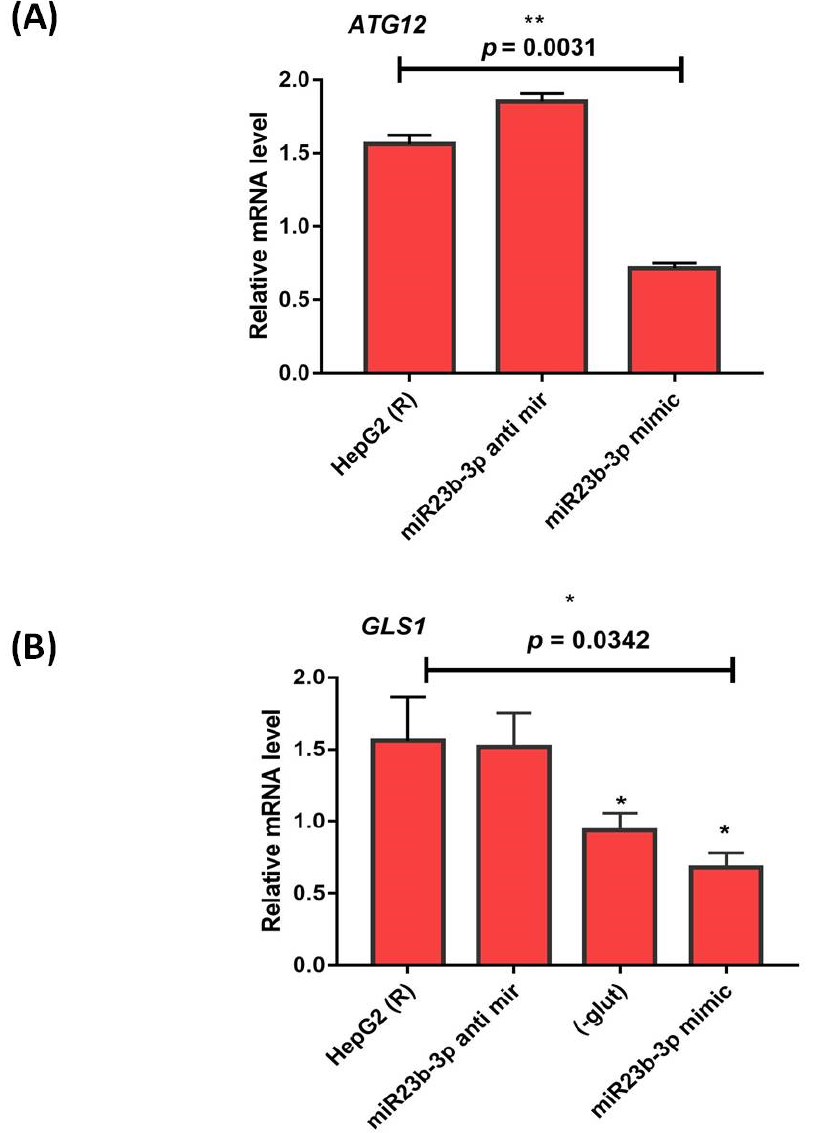
Figure 10. ( A ) ATG12 expression analysis ( B ) GLS1 expression analysis in presence of miR-23b-3p mimic (miR-23m) and antimiR (30 nM) in sorafenib resistant HepG2 cells [R; sorafenib resistant HepG2 cells] (* p ≤ 0.05); (** p ≤ 0.01).